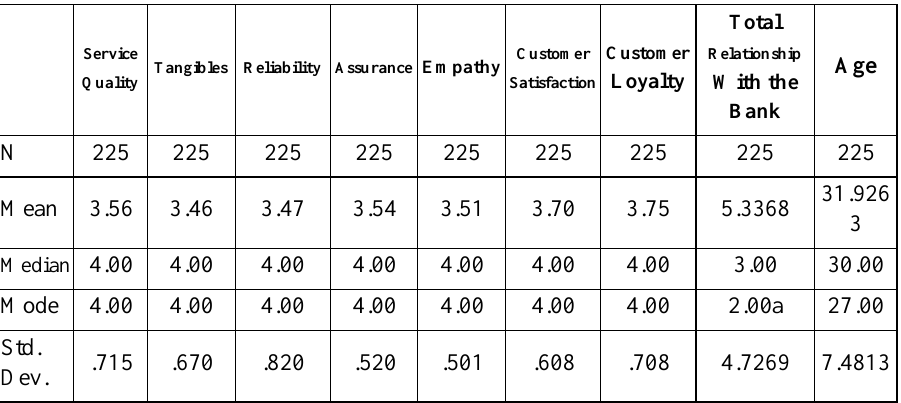
Table 2: Mean, Median, Mode and Standard Deviation scores of Variables of the Study and Demographic Characteristics of the Subjects